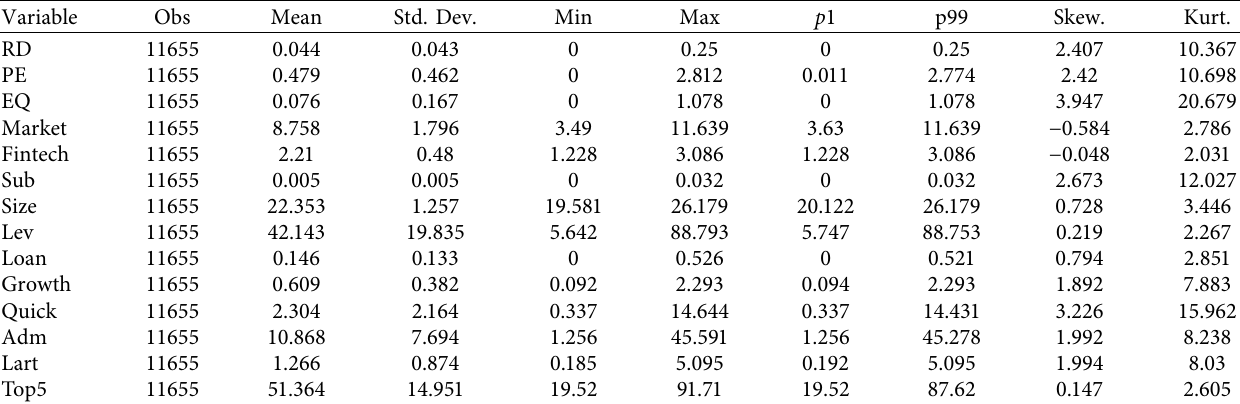
Table 2: Descriptive analysis of